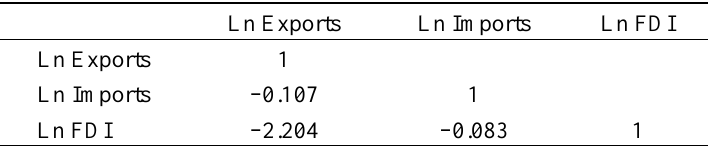
Table 3 . Correlation Matrix of